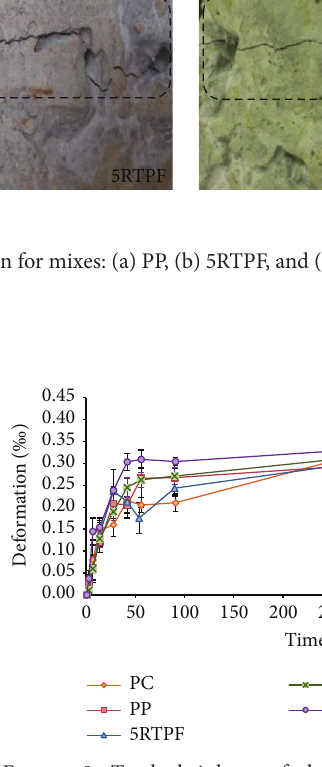
Figure 9: Total shrinkage of the concrete mixes with RTPF, polypropylene fibre, and comparable